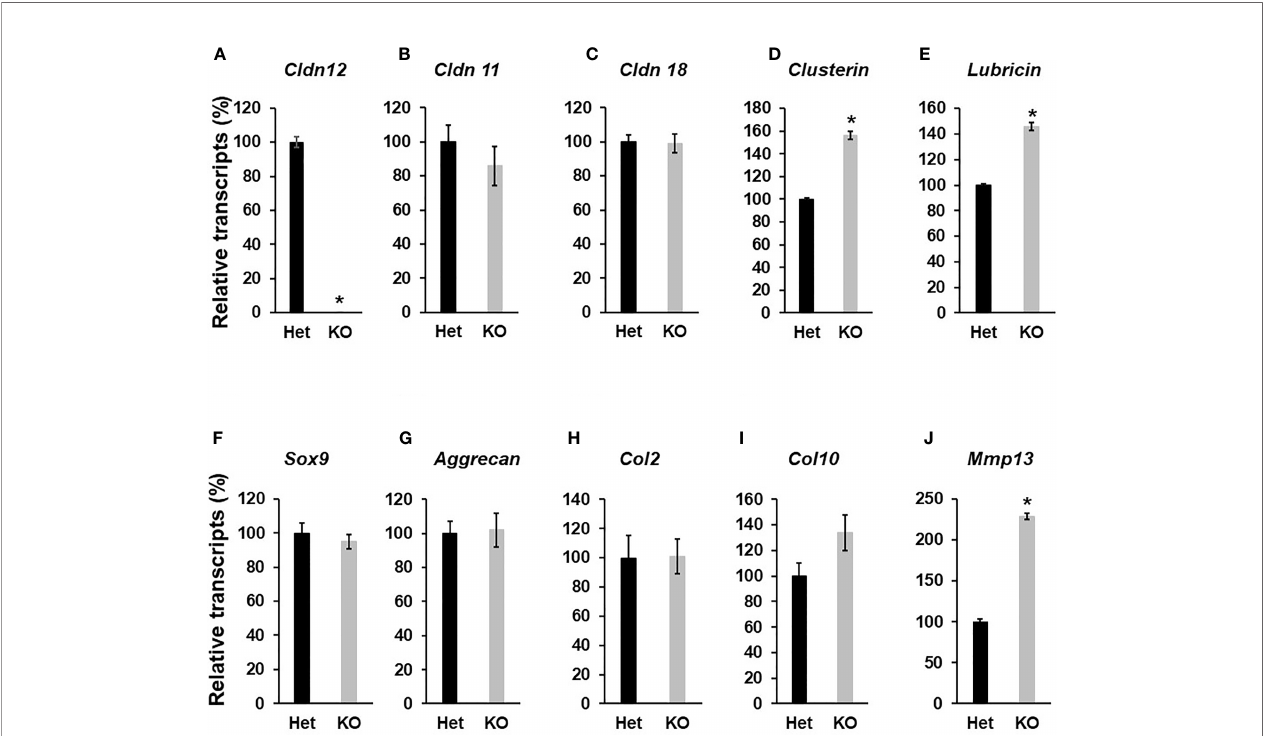
FIGURE 4 | Disruption of Cldn12 inhibits chondrocyte differentiation. Primary articular chondrocytes were isolated from 3 days of the epiphyses of the femur and tibia of newborns. Cells were cultured up to 70% con fl uency, followed by RNA extraction. Total RNA was reversely transcribed into cDNA for quantitative real-time PCR. (A – E) Expression levels of Cldn12, Cldn 11 , Cldn 18 , Clusterin , and Lubricin , respectively. (F – J) Expression levels of Sox9, Aggrecan , and Collagen 2 a 1 (Col2), Collagen 10 a 1 (Col10) , and Mmp13 , respectively. Values are Mean ± SEM (n=4). Star indicates P<0.05, as compared to the control cells derived from heterozygous control mice. A star (*) indicates P<0.05, as compared to the control